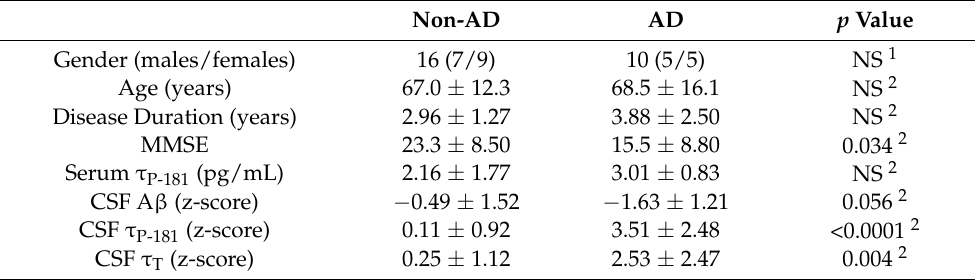
Table 2. Clinical and biochemical data of the subjects (plasma, entire population). Non-AD AD p Value Gender (males/females) 24 (13/11) 12 (6/6) NS 1 Age (years) 69.6 ± 7.51